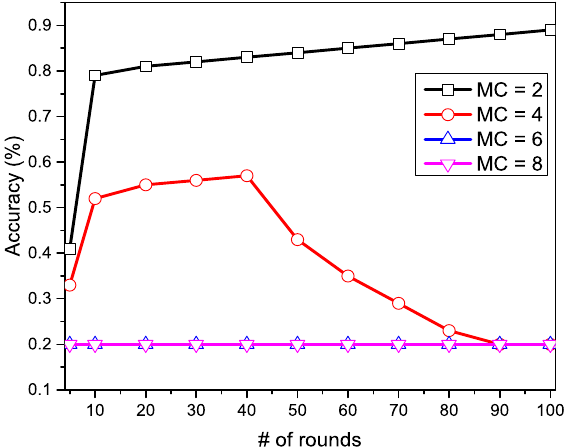
Figure 3. Privacy threat with various number of malicious clients at initialization